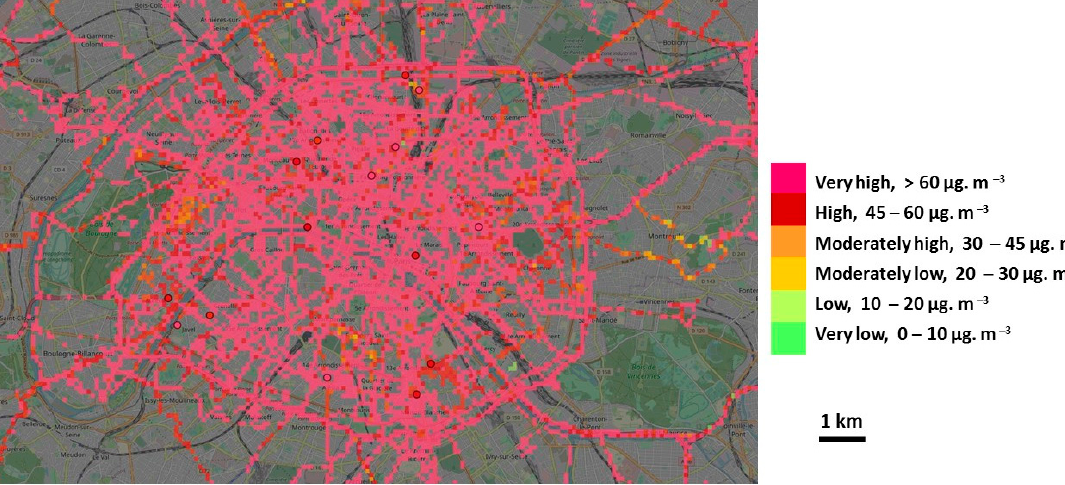
Figure 17. Pollution map in Paris for the 25 January 2020. North is up.